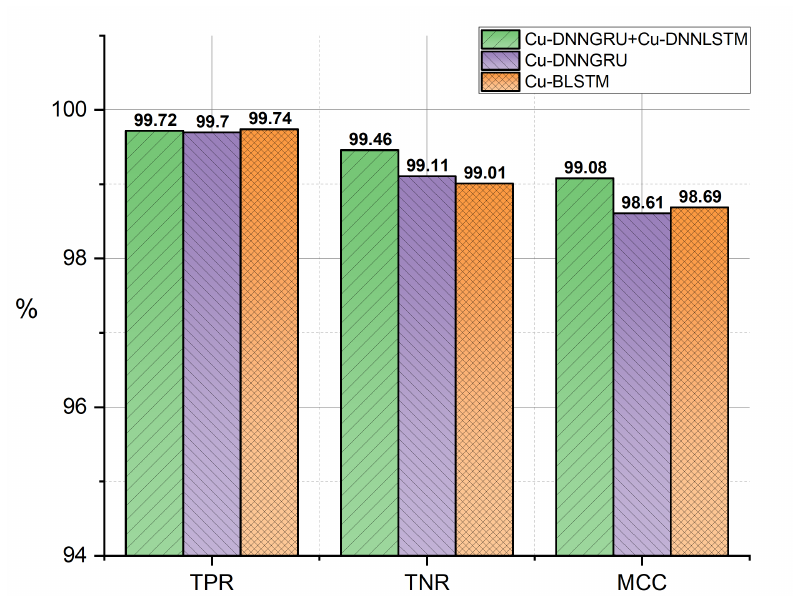
Figure 7. True positive rate (TPR), True Negative rate (TNR) and Matthews correlation coeffi- cient